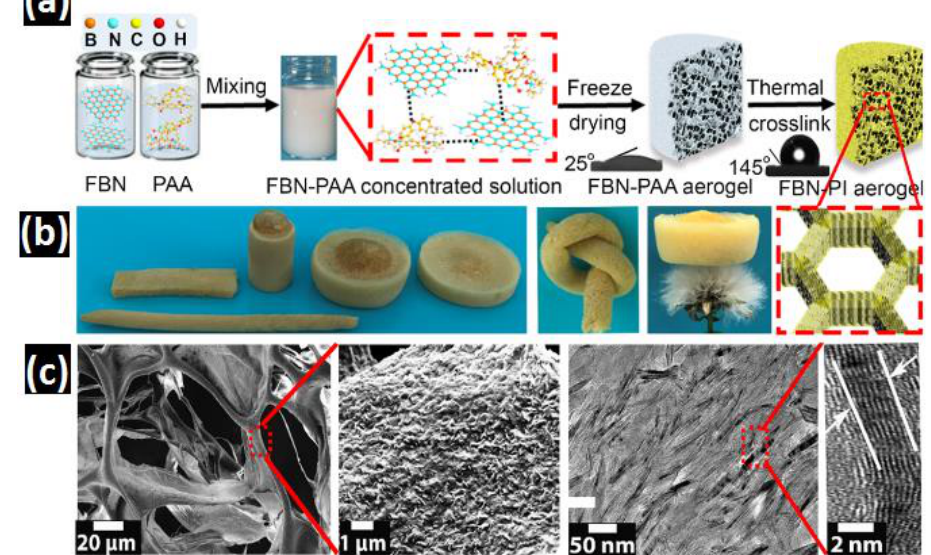
Figure 3. ( a ) Schematic illustration of fabrication procedure, ( b ) photographs of superelasticity